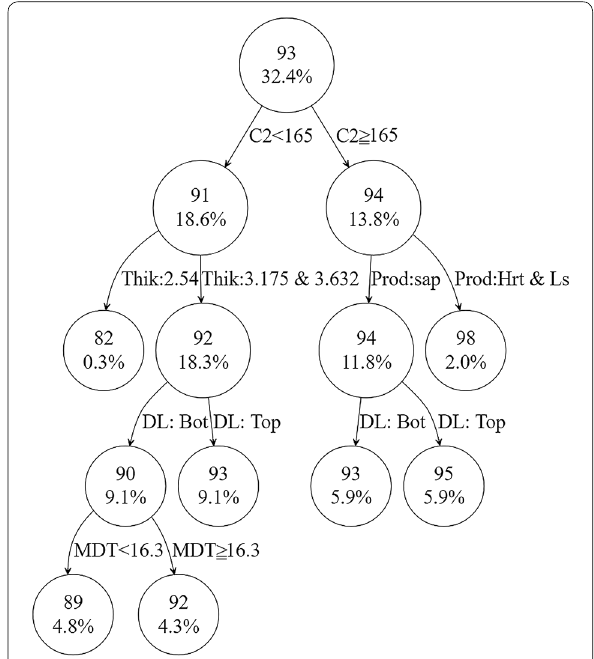
Fig. 6 Part of Fig. 4. The value inside the circles indicates the veneer temperatures in °C and the percentage of the observations